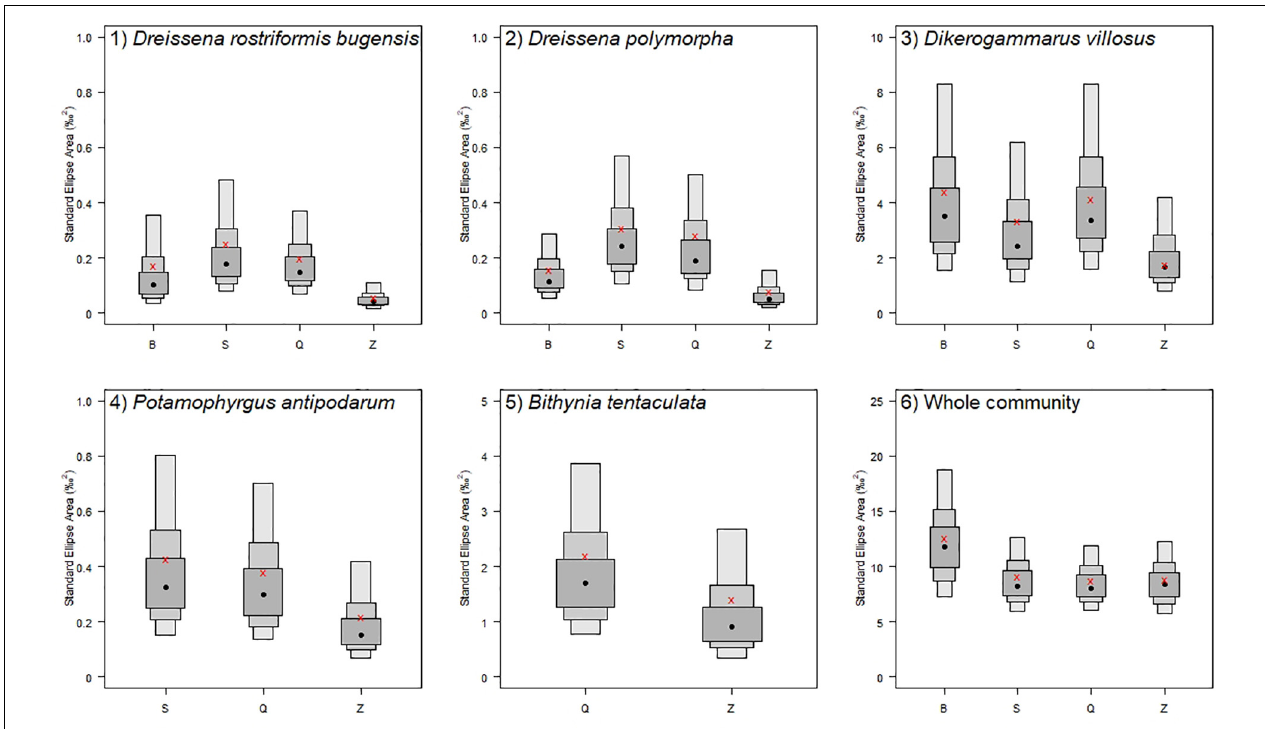
FIGURE 5 | Density plot showing the confidence intervals of the standard ellipse area for five main newly settled macroinvertebrates and the whole community in four different treatments (B, S, Q, and Z). Red crosses correspond to the sample size-corrected standard ellipse areas (SEAc). Boxes shaded from dark to light gray represent the 50, 75, and 95% confidence